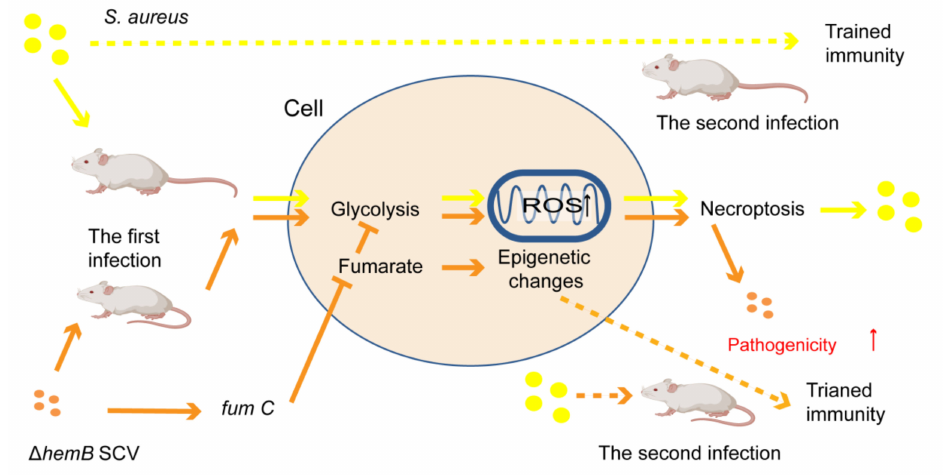
Figure 5. Effects of S. aureus ∆ hemB SCV infection to mice. This figure was drawn according to the report of Lung et al.